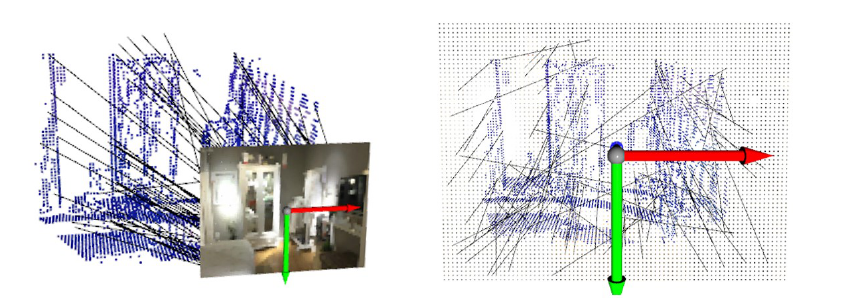
Figure 5. Matching result from brute-force search(3D).